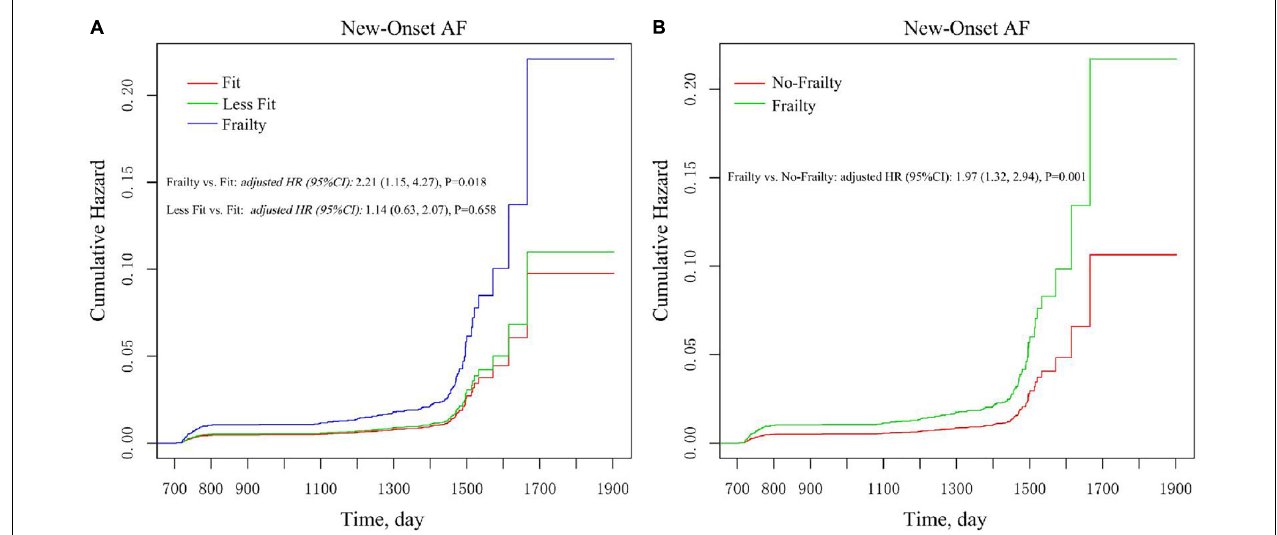
FIGURE 3 | Multivariable-adjusted Kaplan–Meier estimation of new-onset AF by baseline frailty status. (A) Frailty vs. less fit vs. fit. (B) Frailty vs. no frailty. Adjusted for all covariates in the Model 3.